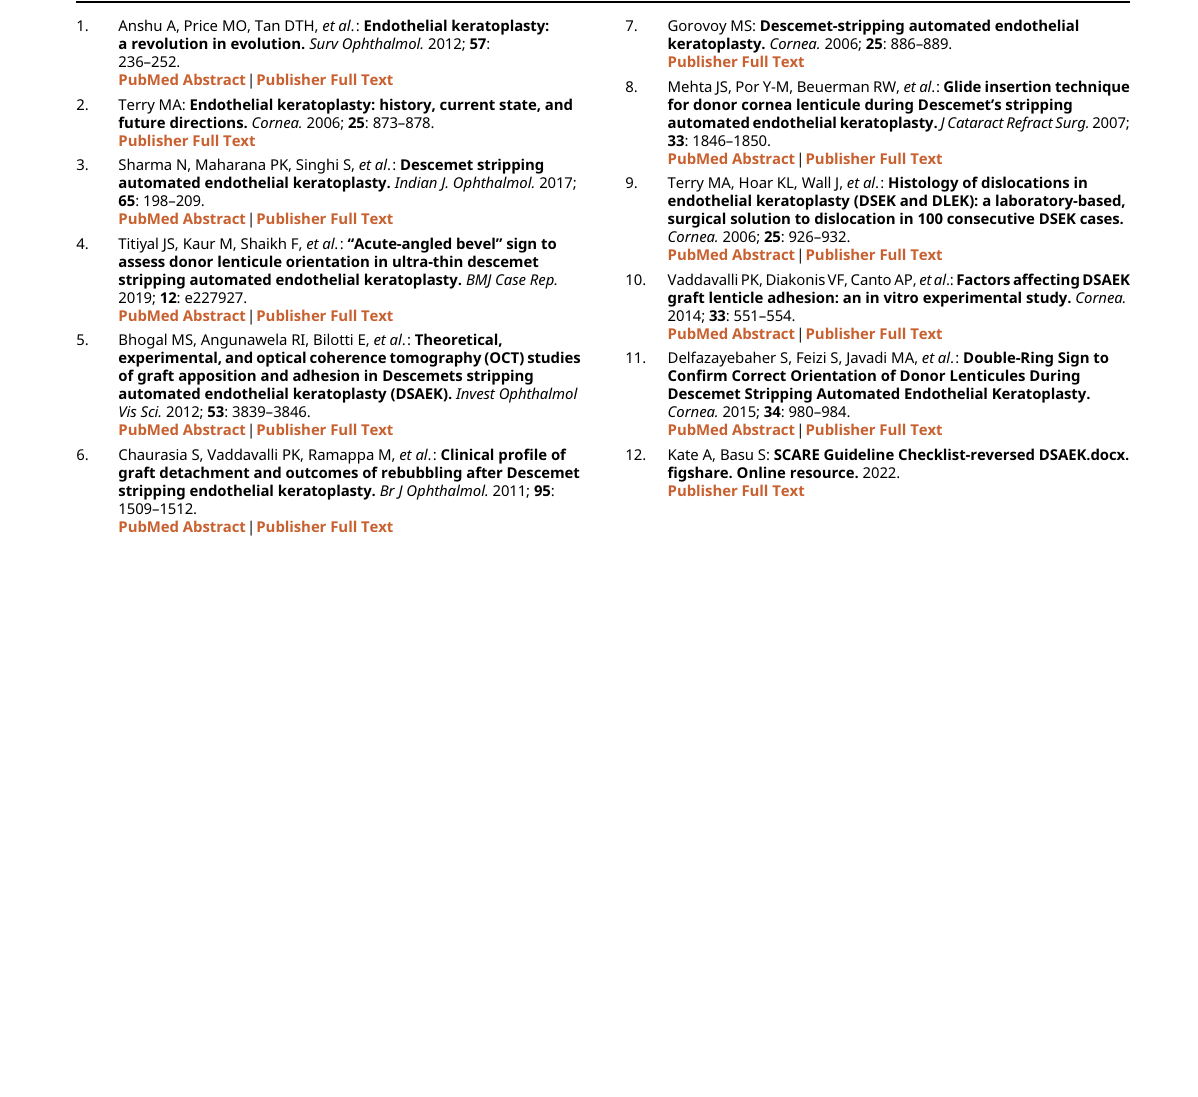
Figshare. CARE guidelines. DOI: https://doi.org/10.6084/m9.figshare.20501754.